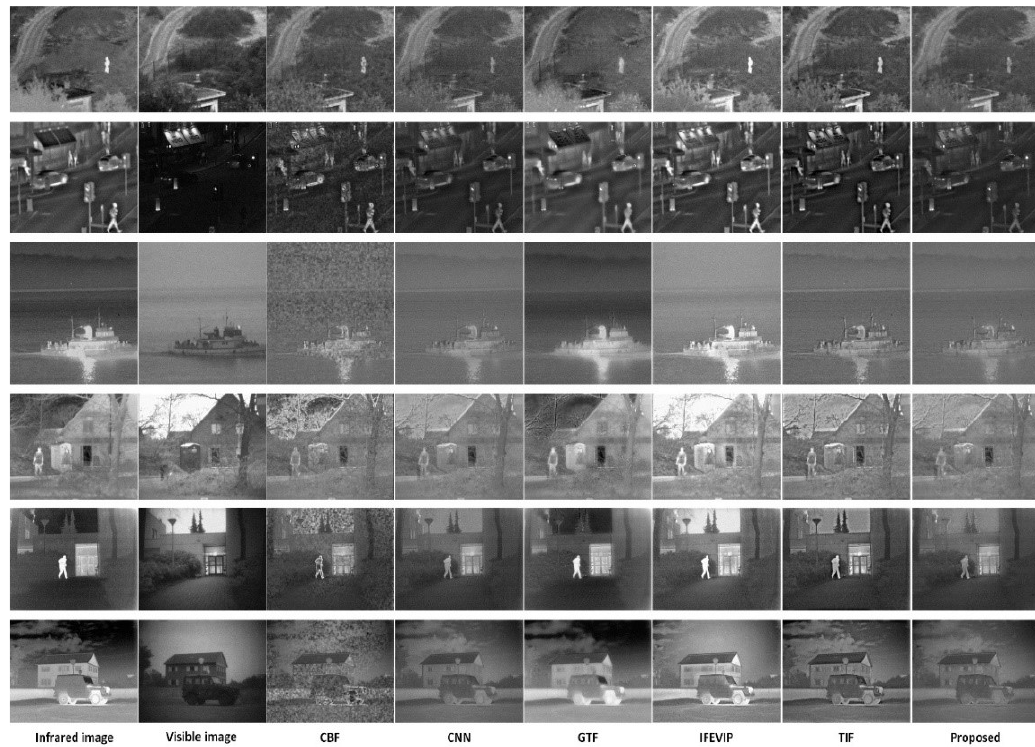
Figure 9. Fusion results of noisy images ( σ = 10).